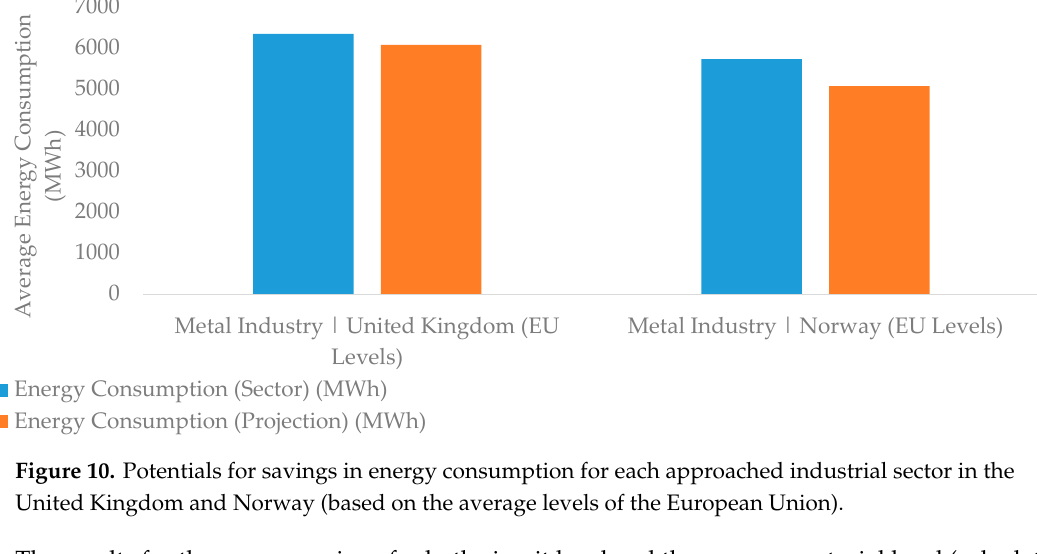
Table 13. Potential energy savings in each industrial sector at EU level.